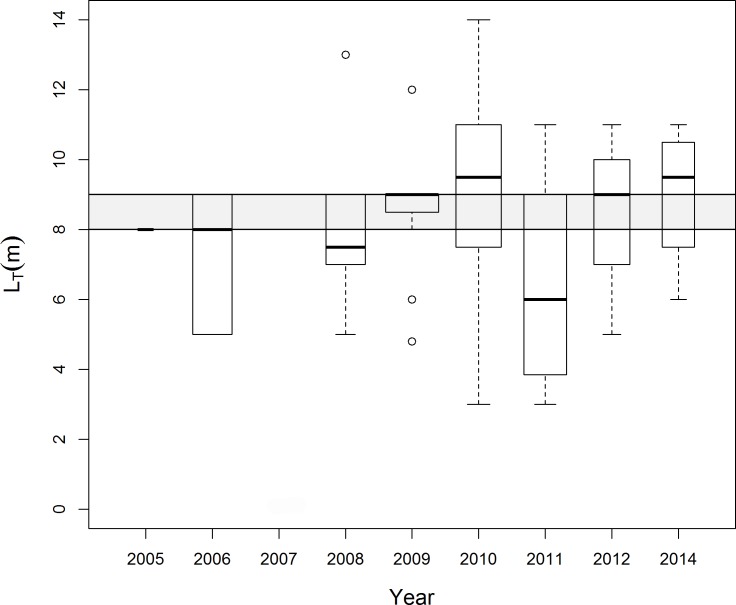
Annual distribution of whale shark lengths.Size distribution per year (SURV; n = 43) in the ASPSP. Immature (below) and mature (above) animals are separated by the shaded area indicating the transitional 8.0–9.0 m size class. The width of the boxes is proportional to the square-roots of the number of observations in the groups, the horizontal bar is the median and the open circles indicate outliers.